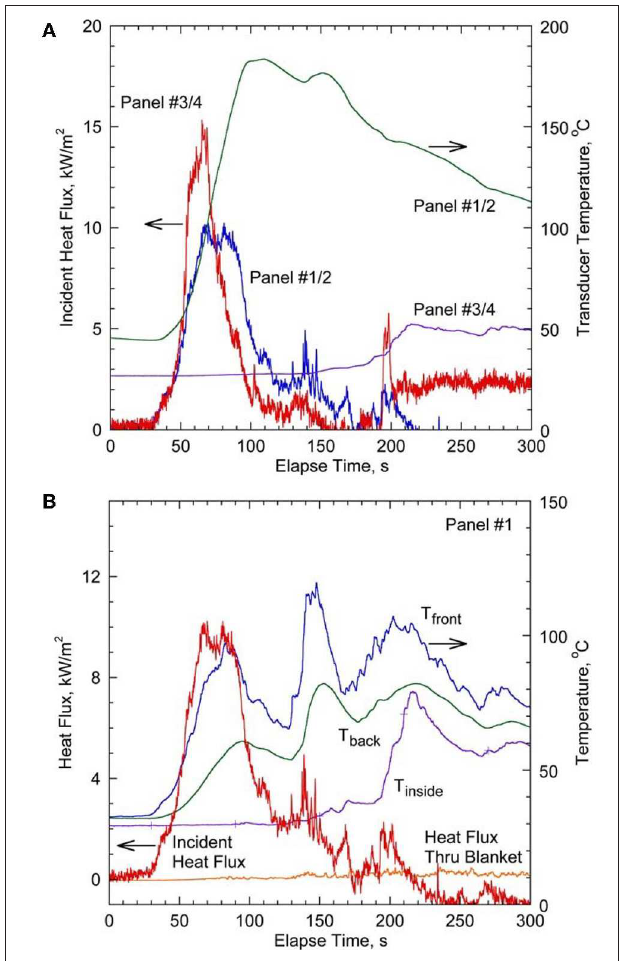
FIGURE 5 | Measurements in Burn #1. (A) The incident heat flux and transducer temperature at the wall locations between the edges of Panels #1/#2 and #3/#4, and (B) incident and through-the-fabric heat fluxes and temperatures at the fabric front and back surfaces and the back (inside) of the wood sheath of Panel #1.